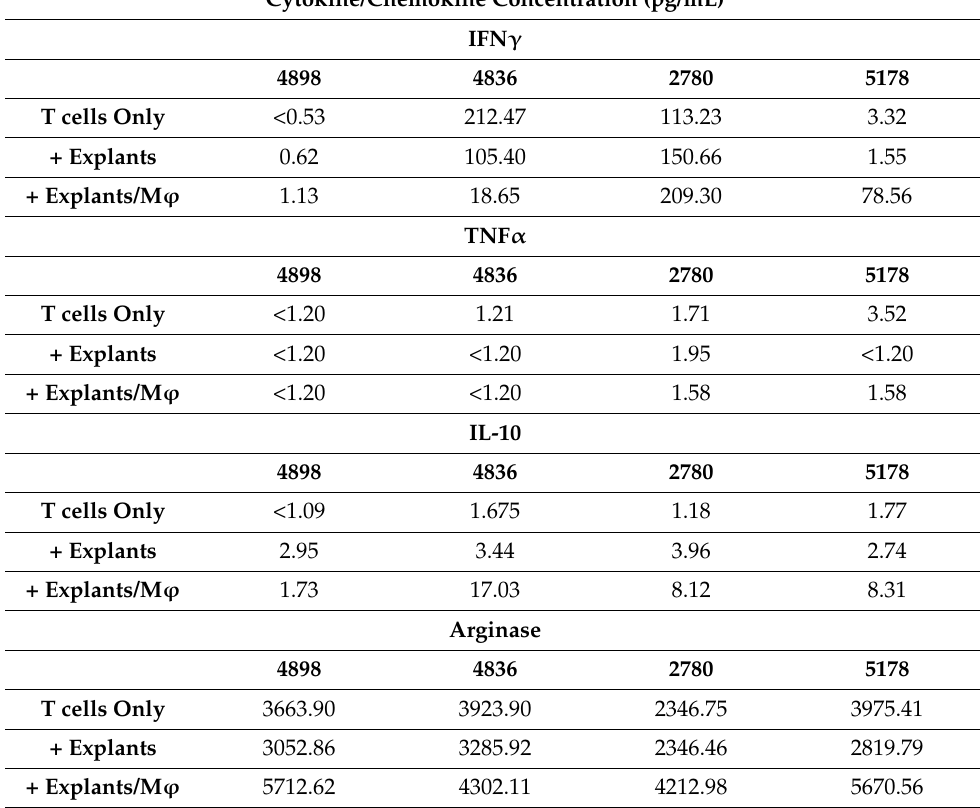
Table 2. The mean concentration (pg/mL) of each target present in culture supernatants was determined using individual protein standards for each of the 4 patient (4898, 4836, 2780, and 5178) experiments. Secretion of all other factors remained unchanged (Table